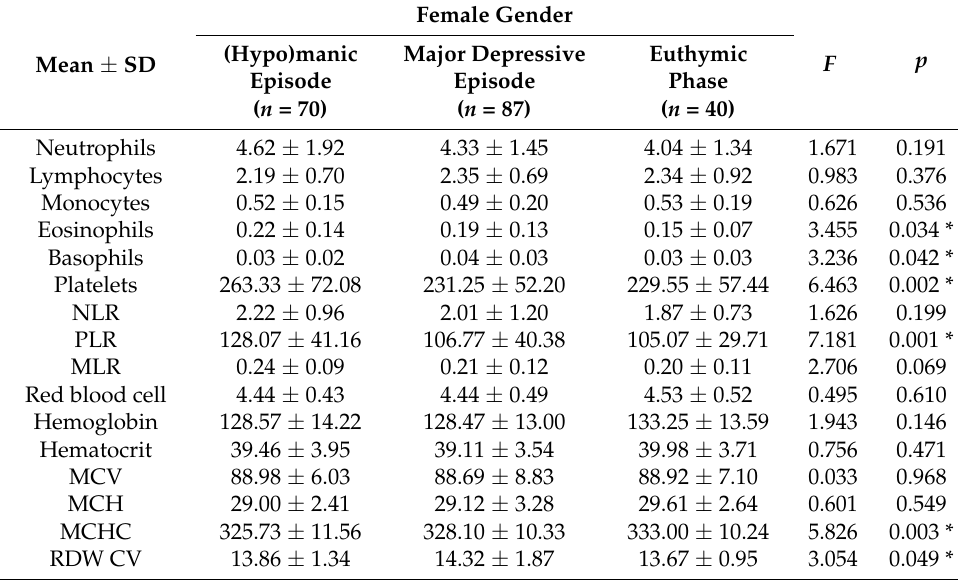
Table 3. Differences in complete blood count and inflammatory ratios in bipolar females, according to illness